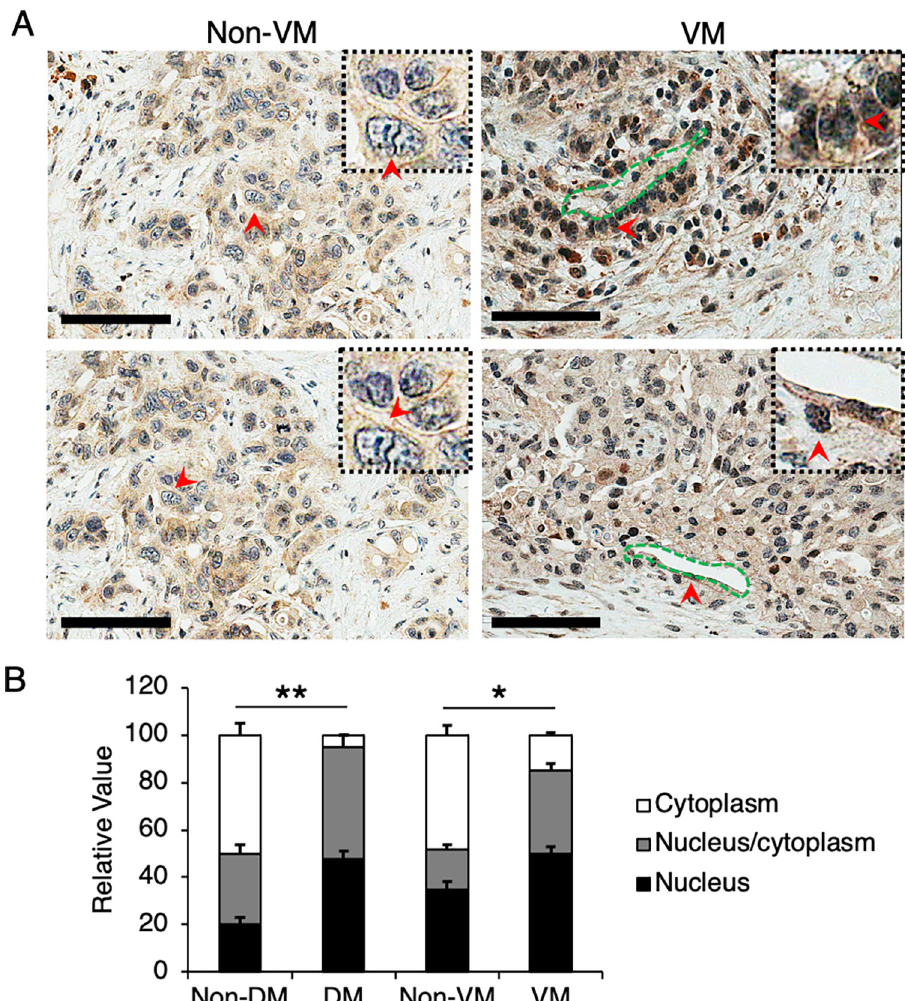
Fig 3. PDAC cells lining VM channels showed strong NOTCH1 expression and activity. (A) PDAC tissues were immunostained for NOTCH1 expression and localization in both non-VM and VM tissue samples. (B) NOTCH1 were quantitated based on the localization of the signals: Cytoplasm, nucleus/cytoplasm, and nucleus. Red arrows, NOTCH1-positive nuclei. Scale bars, 200 μ m. Data presented ± S.D. � P value < 0.01, �� P value < 0.001 (n = 4–5).